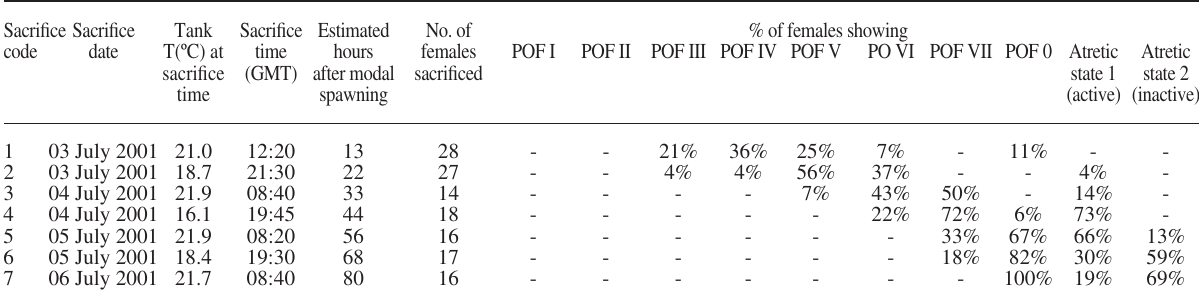
Table 5. – results of the gonad analysis of the females from aquarium experiment g (controlled temperature), presented by sacrifices, date and time (gMt) of each sacrifice and elapsed time after assumed modal spawning time. daily minimum temperatures were registered between 15:00 and 17:00 h every day, being 13.9ºc on the first 2 days of the experiment and 13.1ºc on the third day. sacrifice sacrifice tank sacrifice estimated no. of % of females showing code